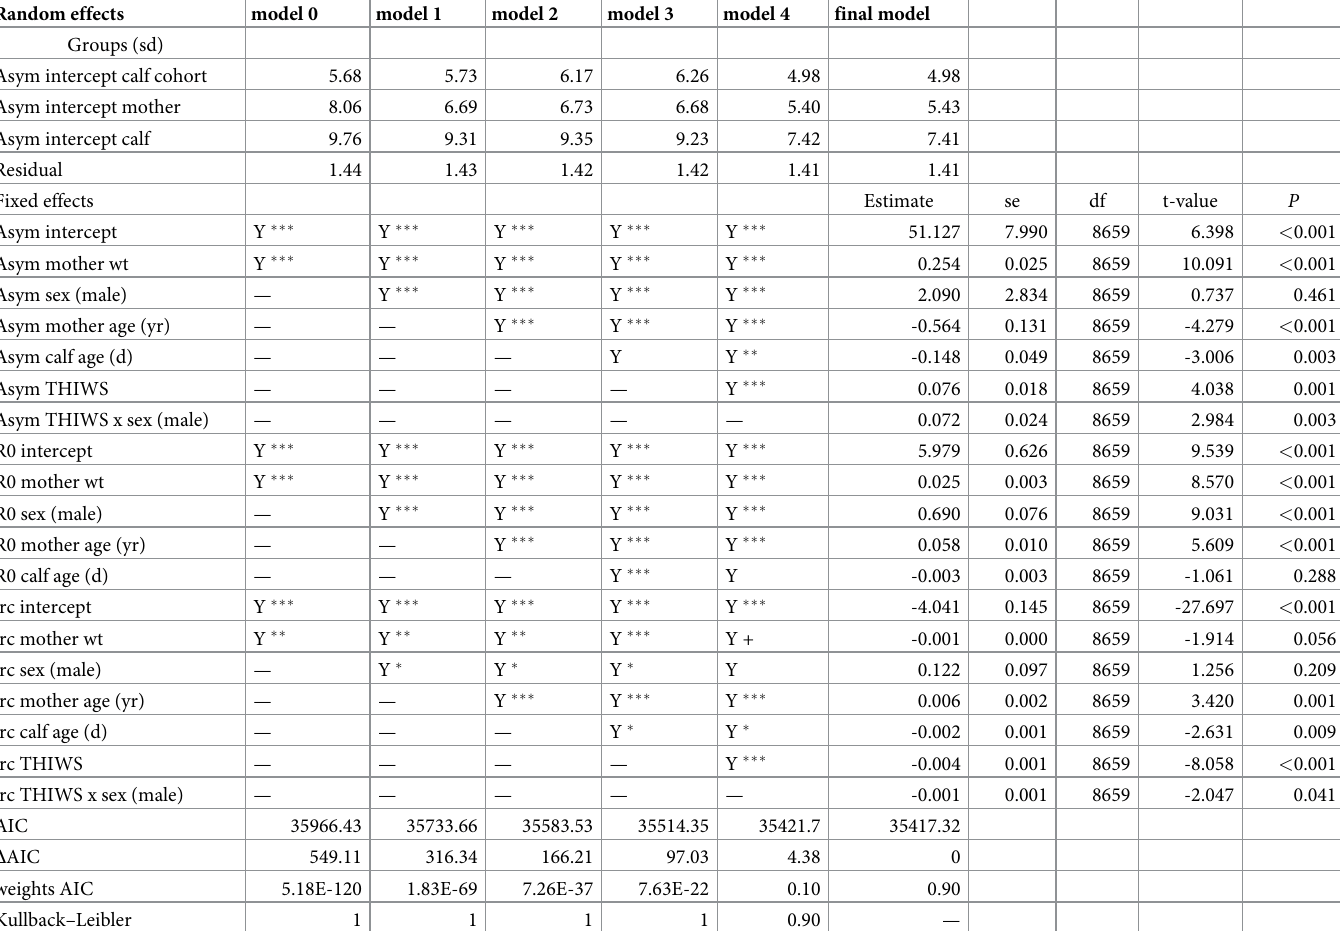
Table 3. Coefficients and statistics of an exponential asymptotic mixed linear model on calf weight (Kg) controlling for animal and a thermal stress index (THIWS) variables. THIWS: stress index based on air temperature, humidity, wind speed and solar radiation; Female is the sex level of reference. Acronyms as in Table 2. Random